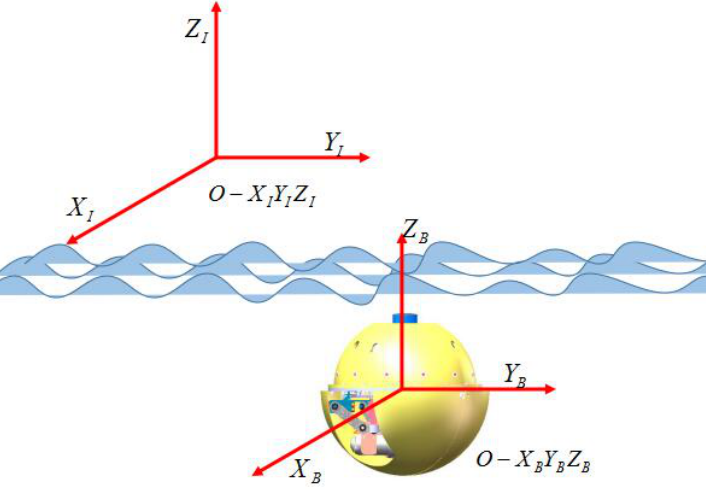
Figure 6. Definition of the inertial frame and the robot body